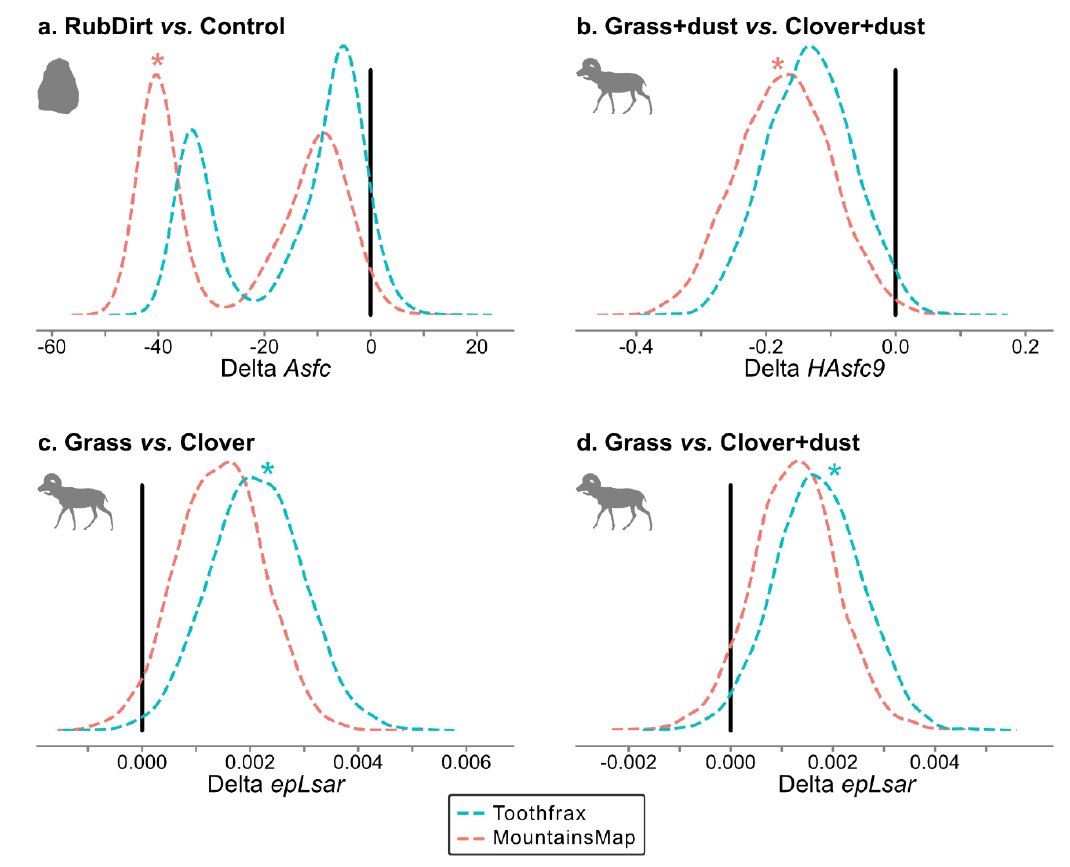
Fig. 5. Contrast plots of treatment pairs for which both software packages disagree on the surfaces with < 5% NMP: Asfc ( a ), HAsfc9 ( b ) and epLsar ( c-d ). Stars mark significant differences for the given treatment pair and software. See Table 2 for 95% HDIs and results on R 2 , Fig. 4 for details on how to read the plots and for abbreviations, Figs 1&3 for details on silhouettes, and text for details on surface parameters and treatments. Table 2. Differences in significance for the two software packages. Only treatment pairs and parameters for which the software packages disagree are shown. For all comparisons, see frames [44], [69], [95] and [128] in the notebook "Statistical_Model_TwoFactor_filter_strong" (folder "Python_analysis/code/" on Zenodo). "True" indicates that the given treatment pair is significantly different for the given parameter and software, i.e. its 95% high probability density interval (HDI) does not include 0. See text for details on surface parameters and treatments. Signif. =